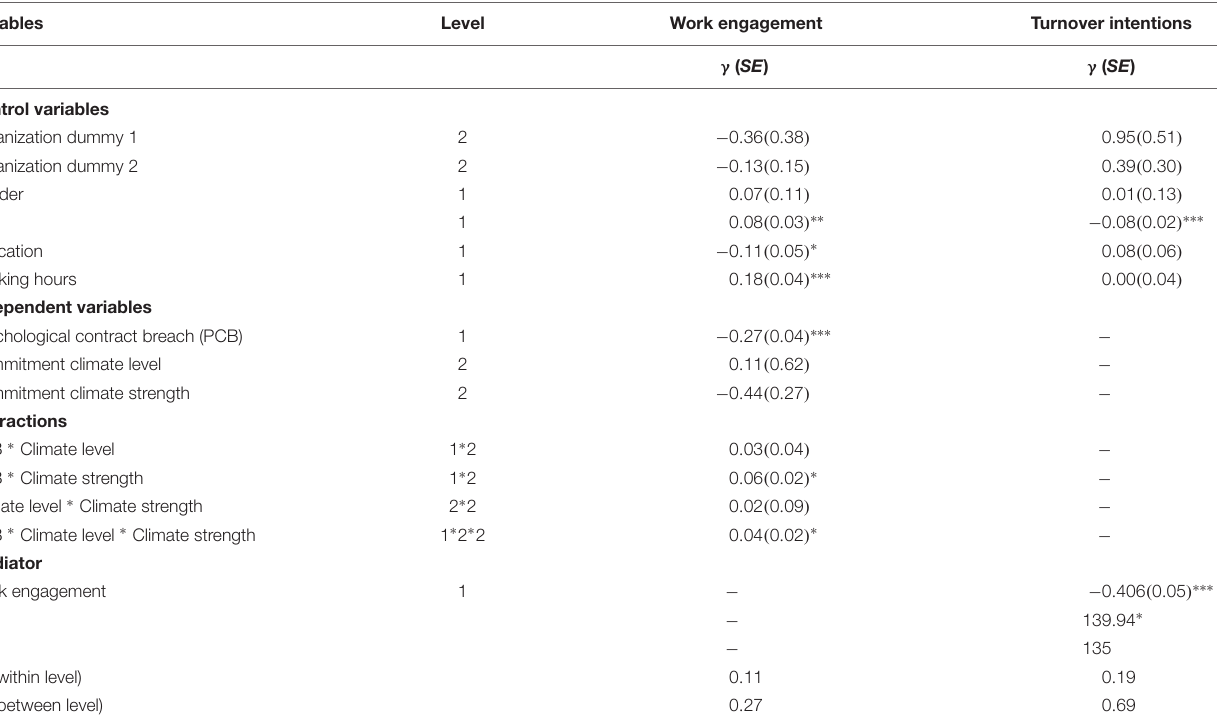
TABLE 3 | Multilevel path analysis of PCB on work engagement and turnover intention, and the moderating roles of commitment climate level and strength.